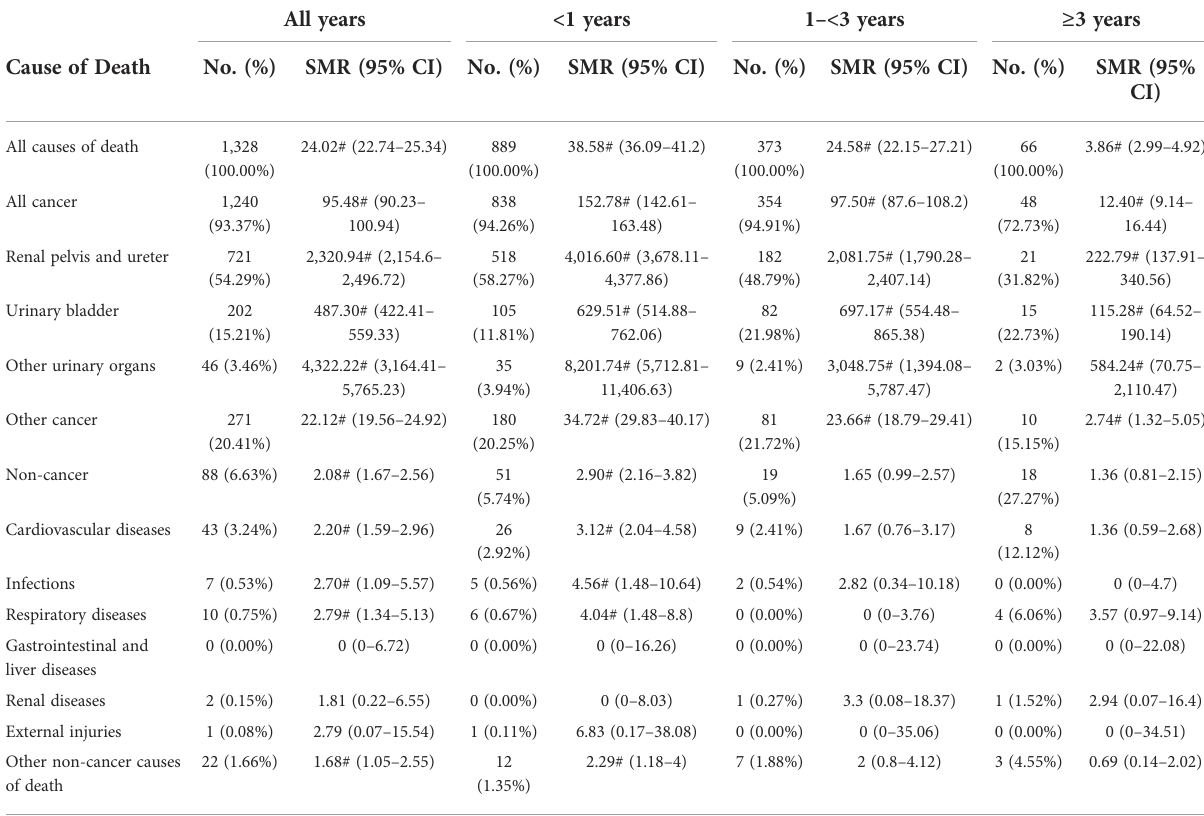
TABLE 5 Causes of death for patients with distant